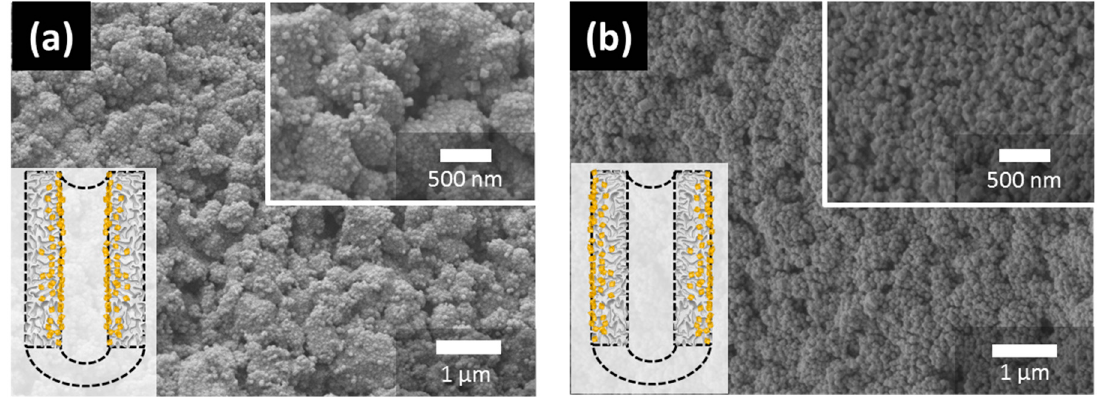
Figure 2. Scanning electron micrographs (SEMs) of ZIF-8 seed layers on the ( a ) bore side and ( b ) shell side of alumina tubes after microwave seeding.